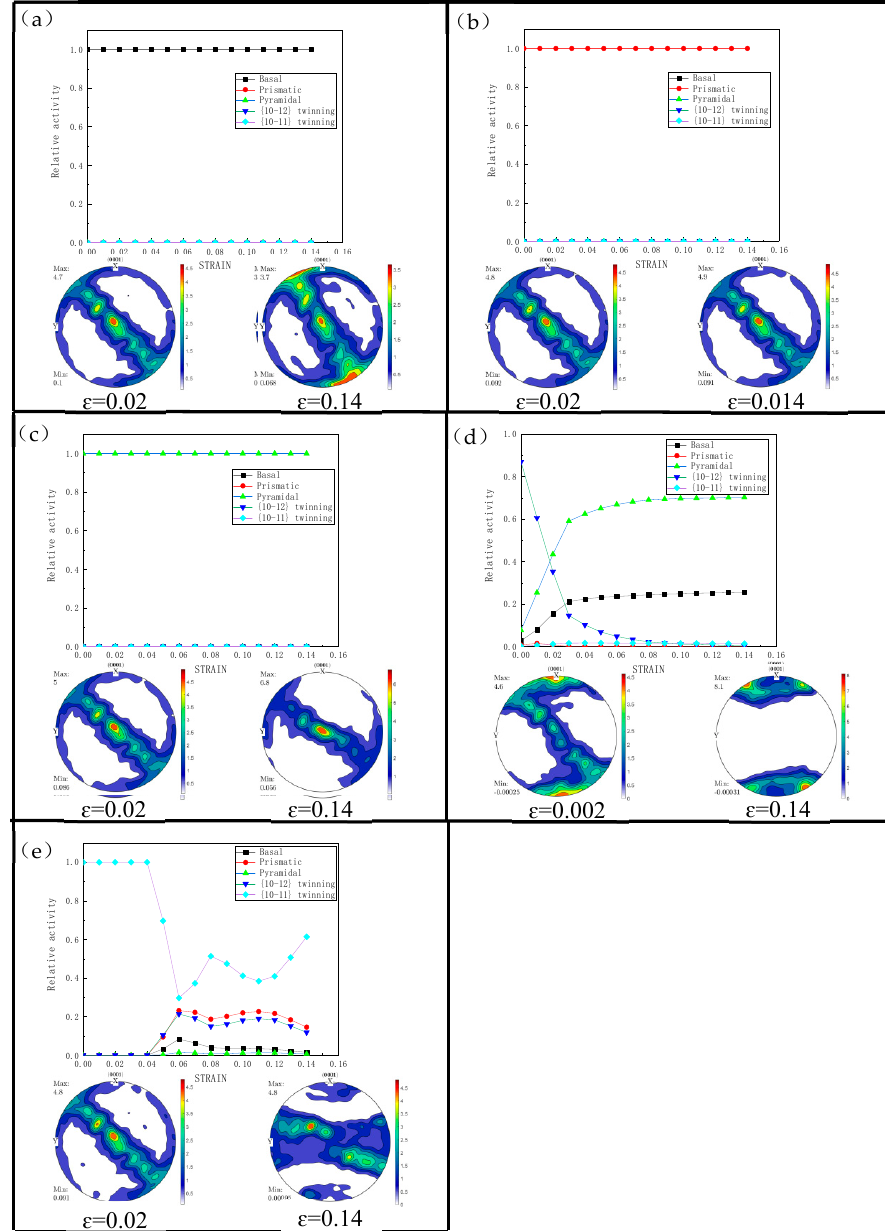
Figure 10. The relative activities of slips and twinning and the simulated texture evolution com- pression in the ED with ( a ) basal slip, ( b ) prismatic slip, ( c ) pyramidal slip, ( d ) {1012} twinning, and (e) {1012} twinning as the predominant deformation mode.